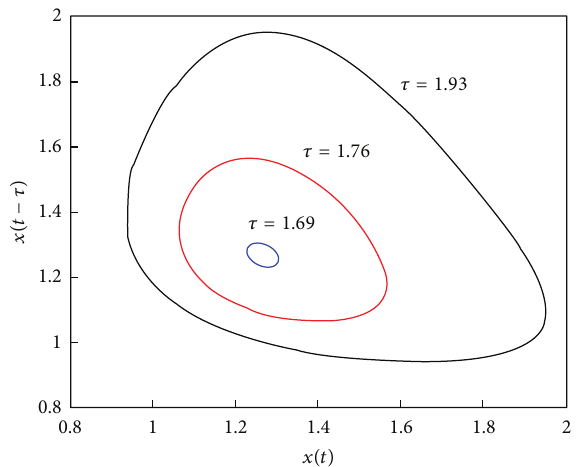
Figure 3: Three different closed invariant curves for three values of 𝜏 : 𝜏 = 1.69 (blue), 𝜏 = 1.76 (red), and 𝜏 = 1.93 (black).